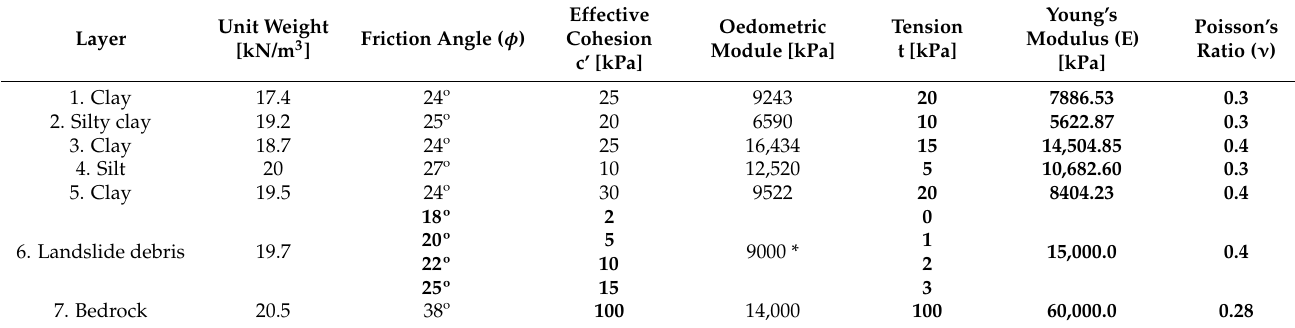
Table 2. The geotechnical properties that are assigned to the materials in the numerical modeling.